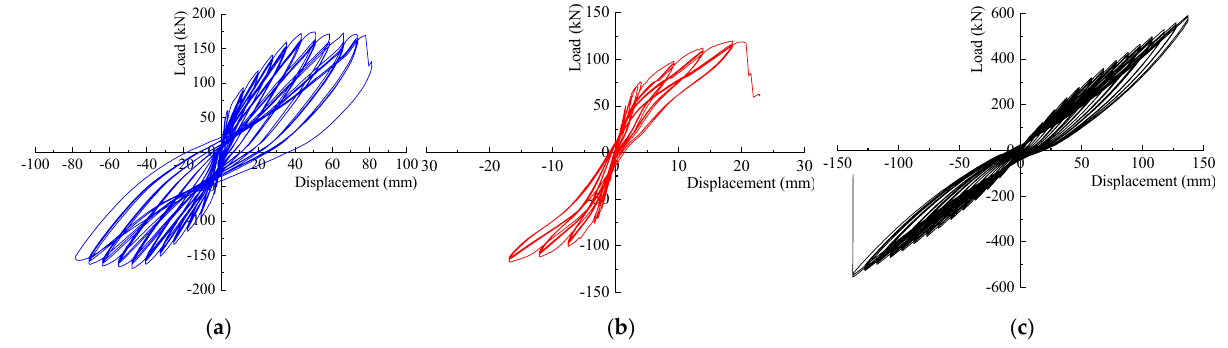
Figure 10. Load–displacement hysteretic curve of each column specimen: ( a ) PRC tube column; ( b ) PHC tube column; ( c ) BFRPC composite column. ( b ) PHC tube column; ( c ) BFRPC composite